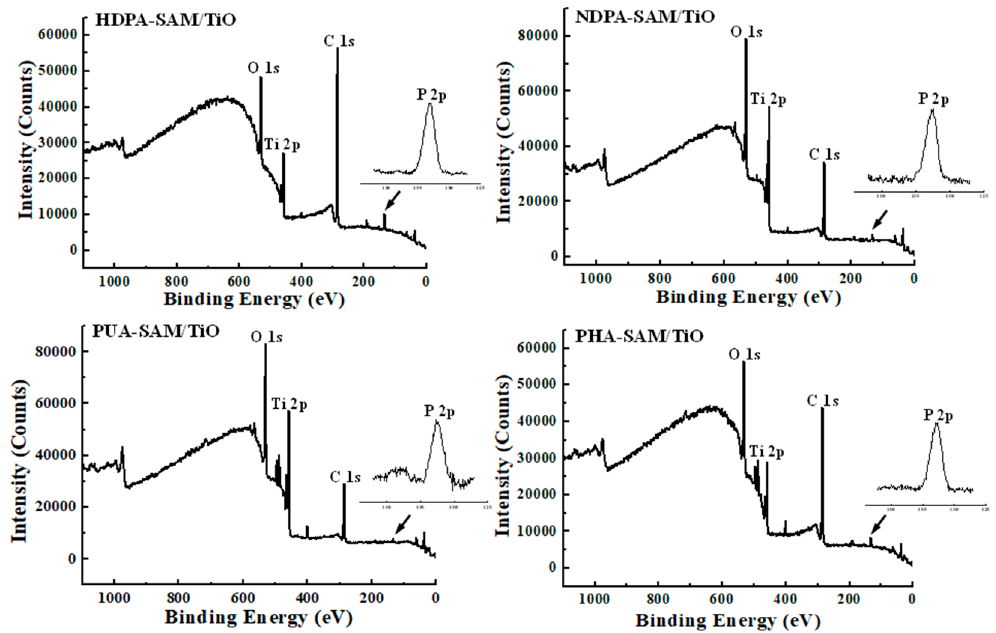
Figure 3. ( a ) The high-resolution XPS survey spectrum of the TiO sample and ( b ) the regional scans of O 1s peaks taken from the TiO sample surface.